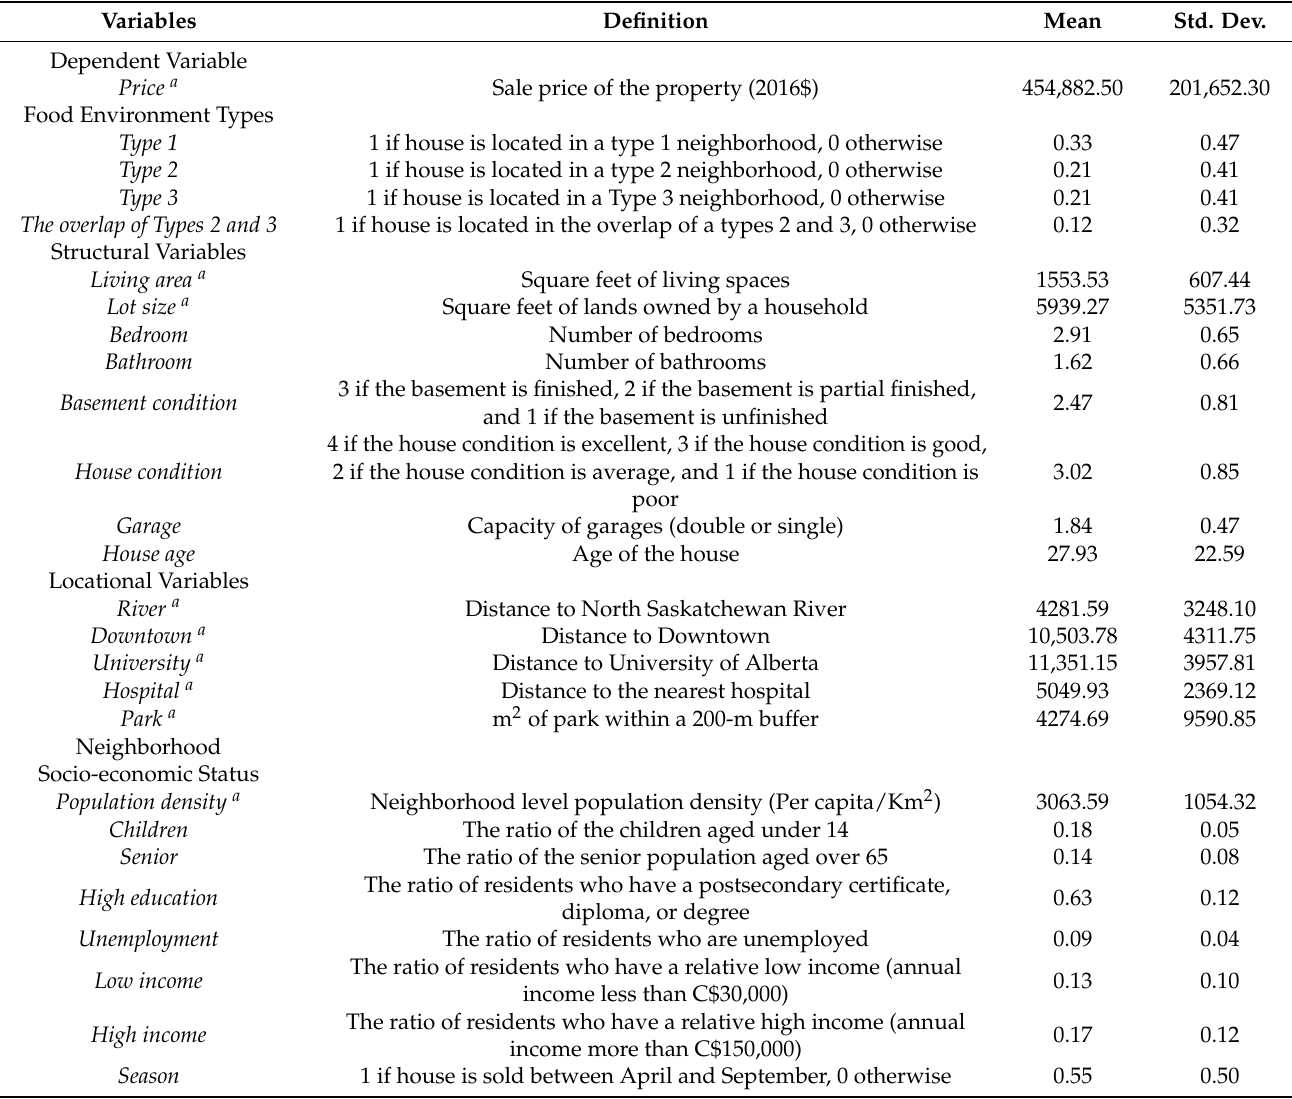
Table 1. Variable Definitions and Summary Statistics (n =